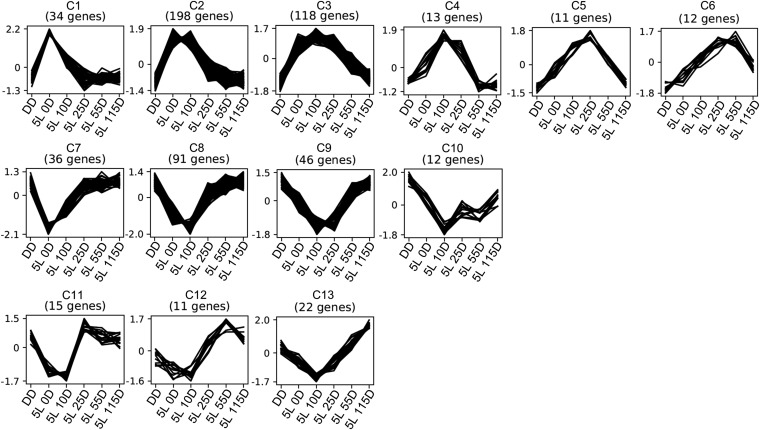
Clustering analysis for light-regulated genes resulted in 13 clusters depicting upregulated (C1 through C6), downregulated (C7 through C10), and oscillatory (C11 through C13) genes. Values in y-axis are Z-scores.